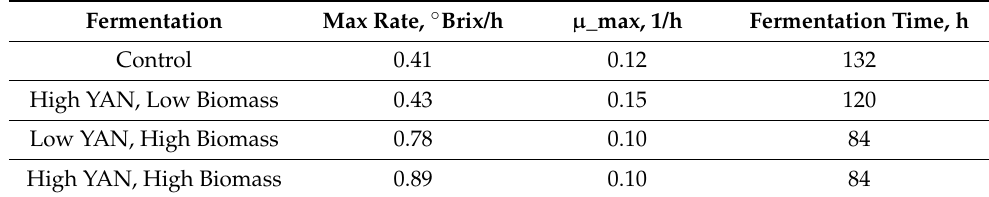
Table 1. Flask fermentation